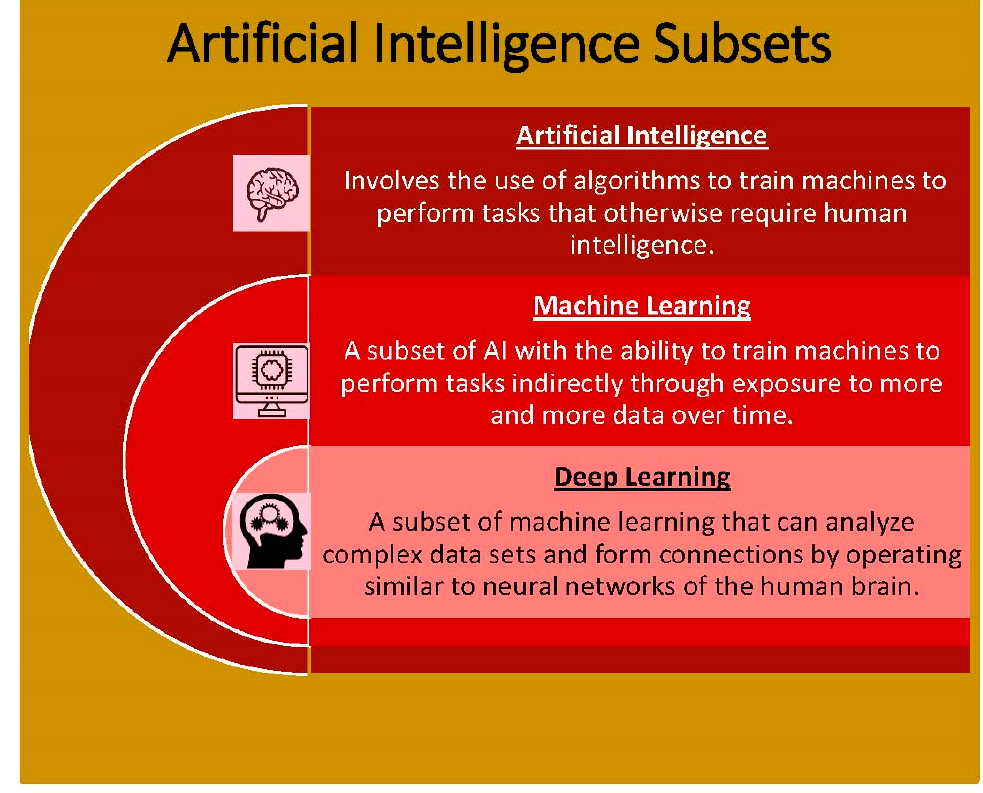
Figure 1. Artificial intelligence subsets into which the principles of AI can be divided.